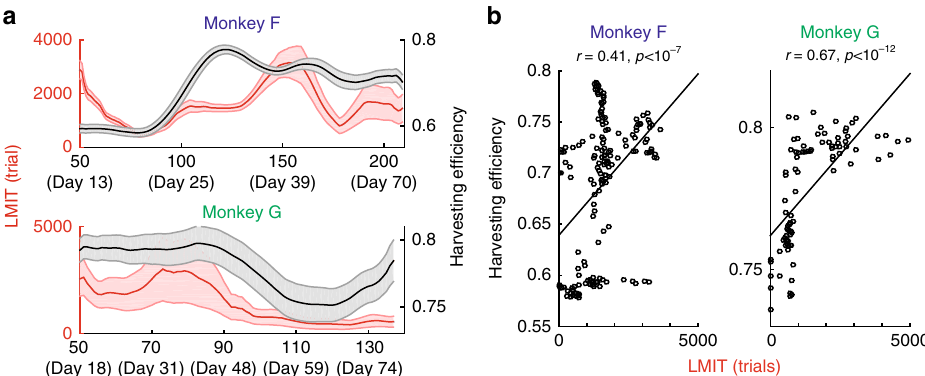
Fig. 8 LMIT is also correlated with harvesting ef fi ciency in data, as predicted by our modeling analysis. a Changes in LMIT (same as in Fig. 7) and harvesting ef fi ciency. The harvesting ef fi ciency was computed for each session, then taken the mean over each reference window to match the estimated LMIT. b The LMIT and harvesting ef fi ciency show a signi fi cant positive correlation for both monkeys, as predicted by our theoretical analysis (The conservative piece-wise permutation test: p < 10 − 7 for monkey F and p < 10 − 12 for monkey G). This supports our idea that having a very slow learning of reward history, in addition to a fast one, is indeed bene fi